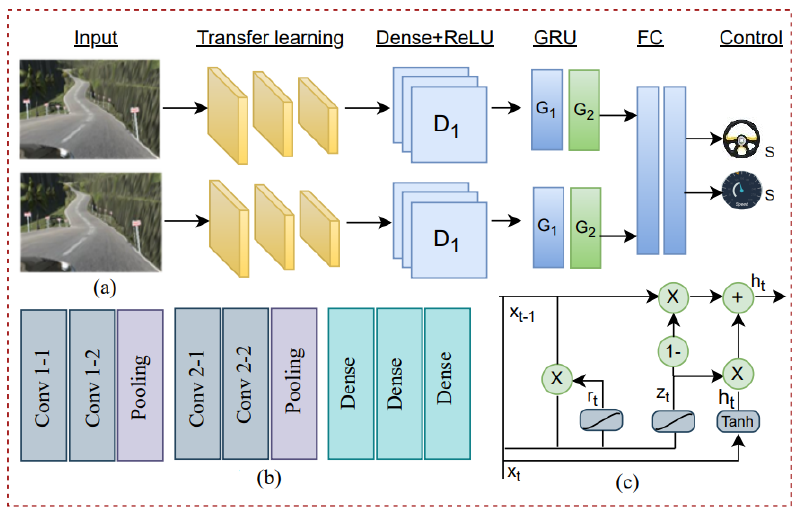
Figure 3. Overall proposed framework: ( a ) three parts: input, the proposed model (VGG-GRU), and the control of the steering angle and speed. ( b ) The overview of the simple VGG16 (GRU). ( c ) The structure of the gated recurrent units